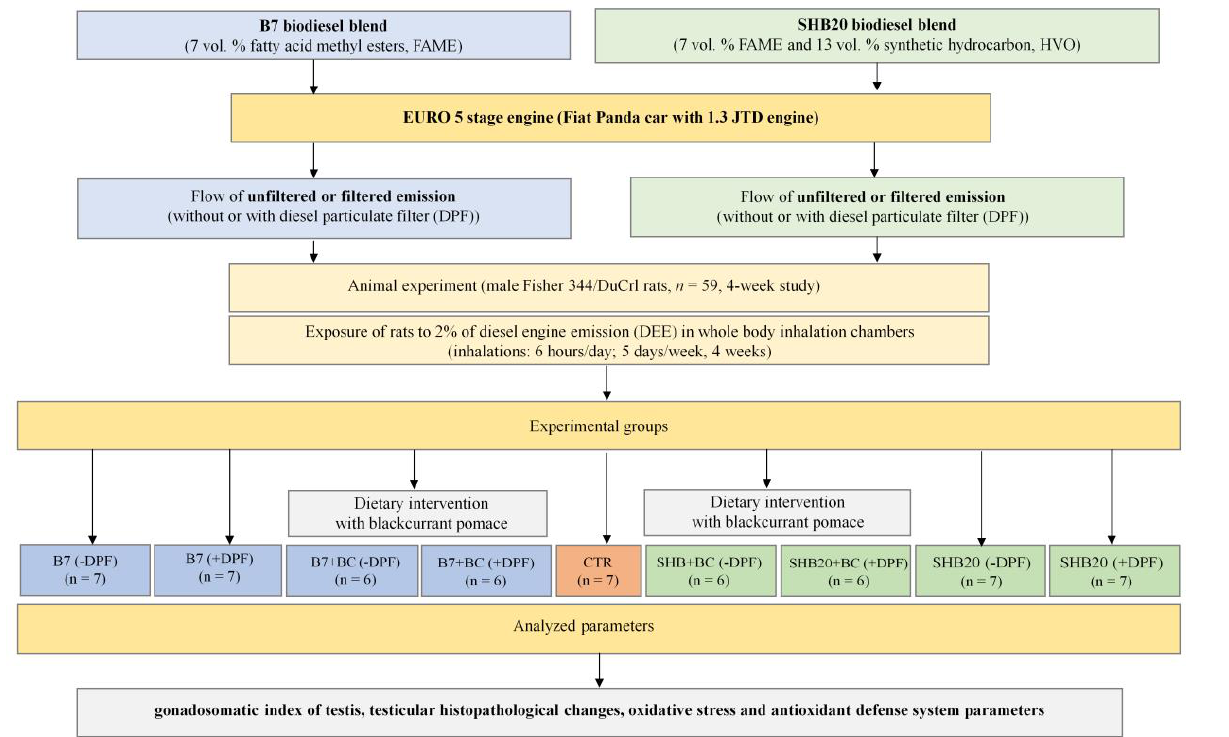
Figure 1. Experimental design of the in vivo experiments. B7 — 1st generation biofuel; SHB20 — 2nd generation biofuel; DPF — diesel particulate filter; DEE — diesel engine emissions; BC — blackcurrant pomace.